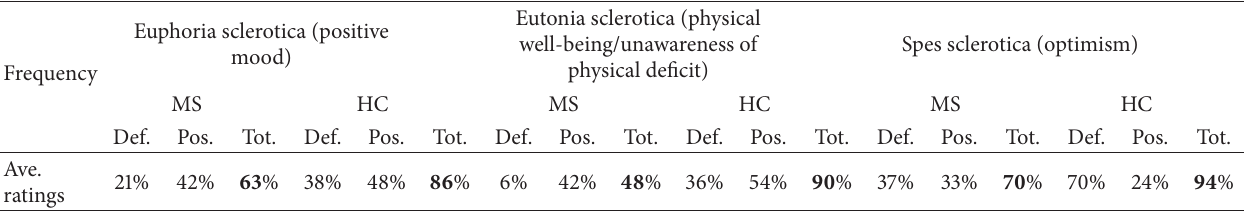
Table 2: Frequencies of euphoria sclerotica, eutonia sclerotica, and spes sclerotica, according to the classical interview of Cottrell and Wilson, among the MS patients and healthy controls ( 𝑁 = 200 ).